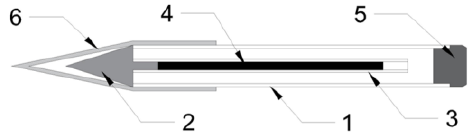
Figure 1. Part structure schematic diagram of a ballpoint pen.